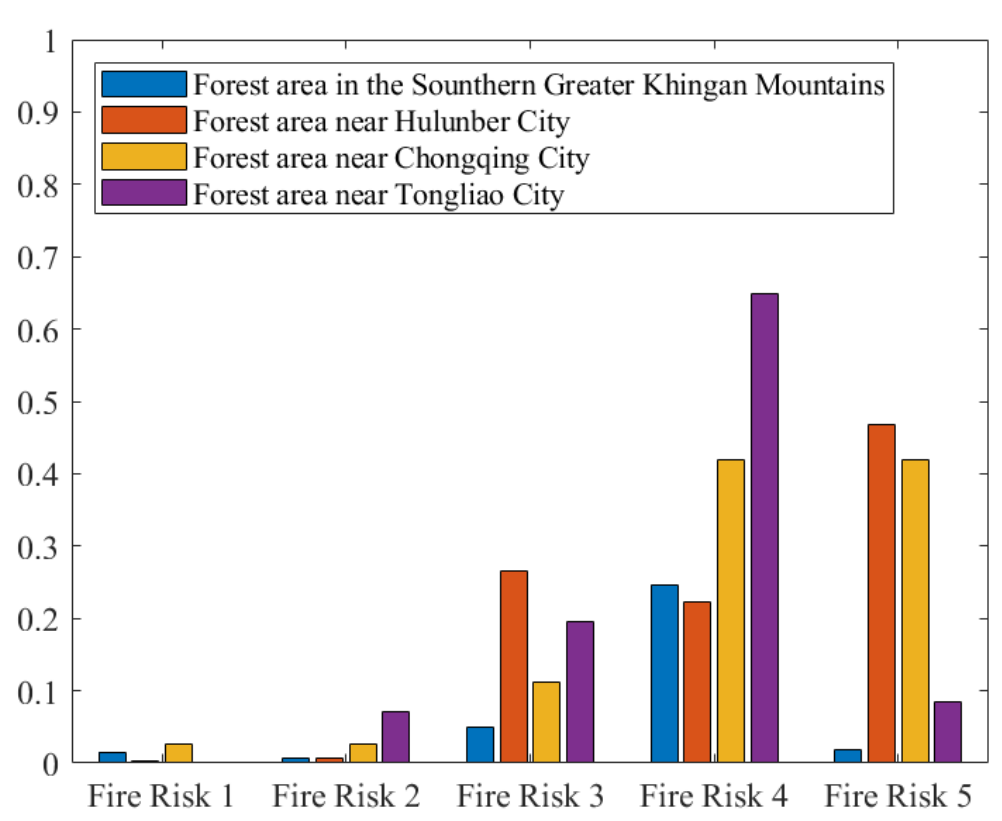
Figure 4. Proportion of forest fire spots falling on each fire danger rating map.